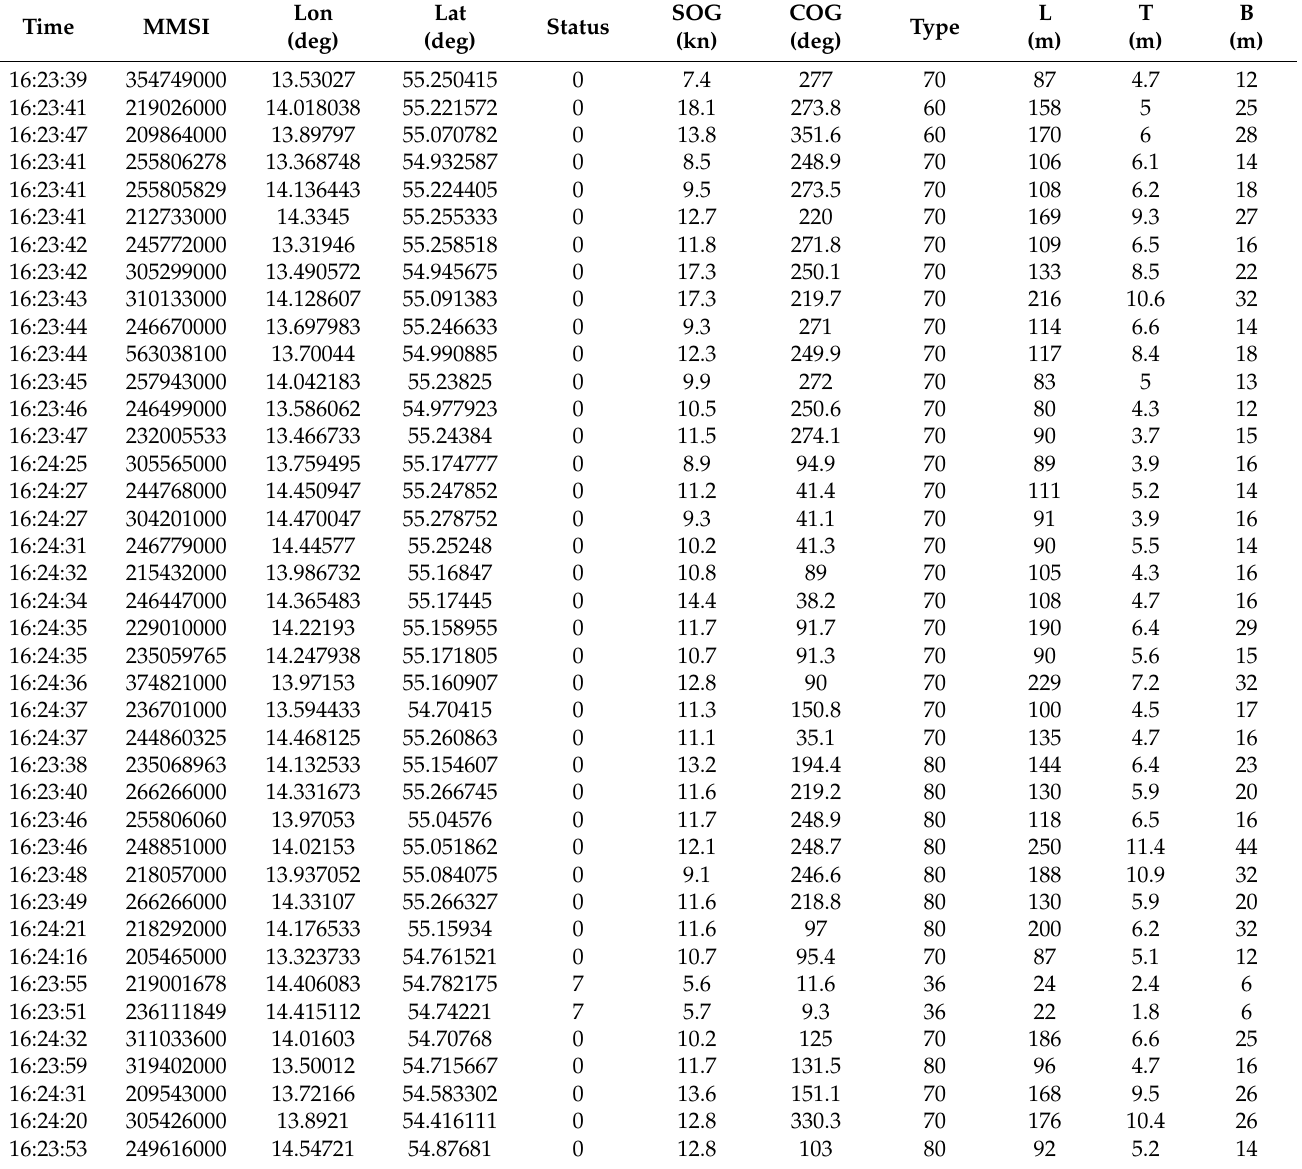
Table 3. Database (of vessels) based on the AIS data, pre-filtered and decoded (authors’ own